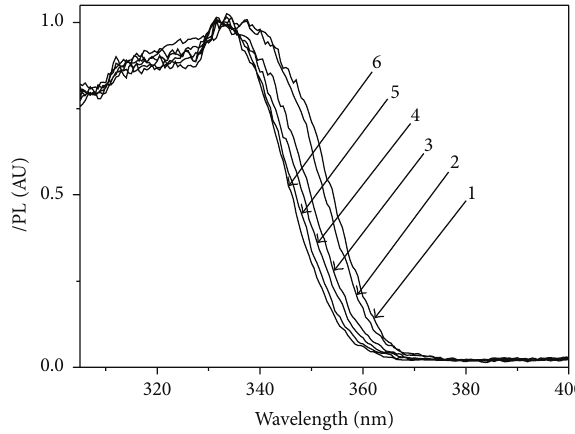
Figure 12: Normalized luminescence excitation spectra of the colloidal solutions of ZnO nanoparticles without SiO 2 (1) and with provisionally adding 0.2 g (2), 0.4 g (3), 0.6 g (4), 0.8 g (5), and 1g of silica (6) to 10mL of zinc oxide solution. [ZnO] = 2 × 10 −2 mol/L, = 540 𝑙 = 0.1 cm, and 𝜆 emission = exc .